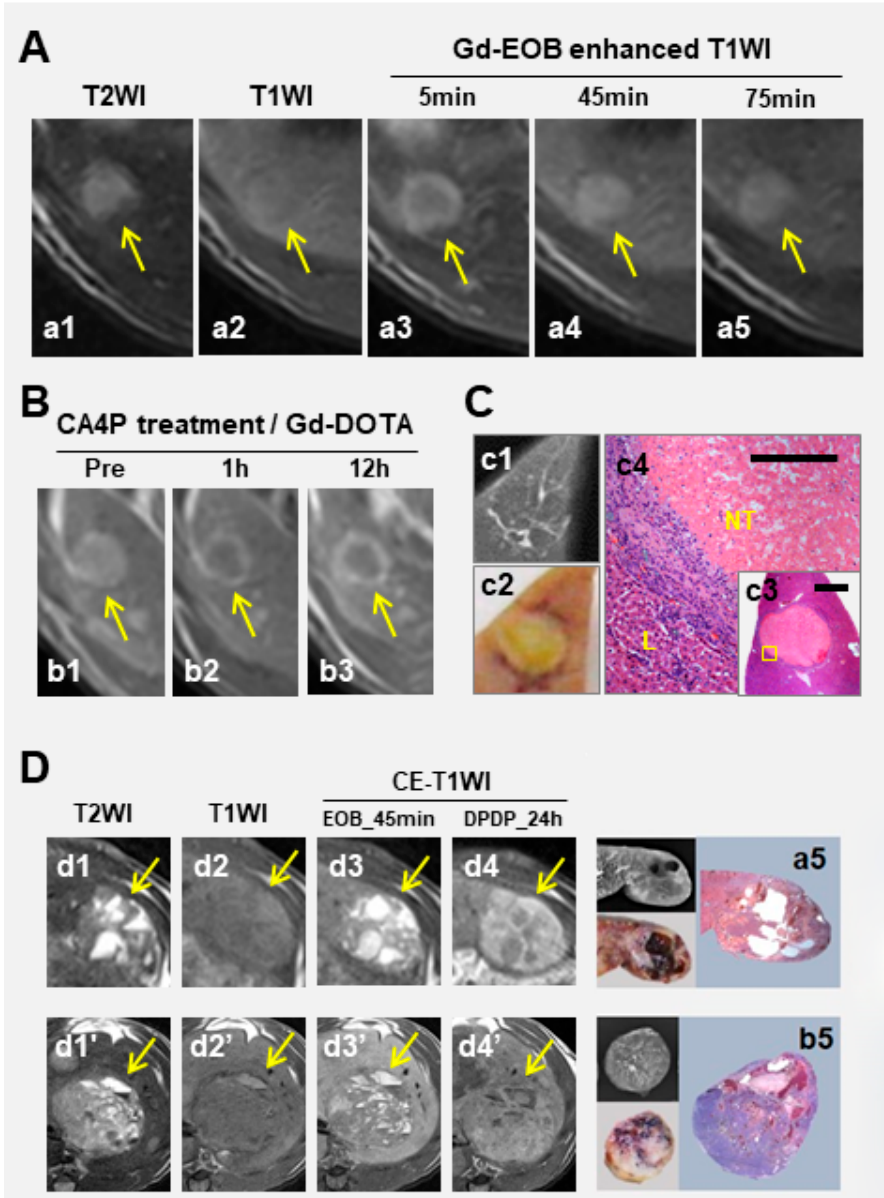
Figure 3. Performance of hepatobiliary contrast agents (CAs) on predicting tumoricidal effect of combretastatin A4 phosphate (CA4P) in well differentiated HCC, and on distinguish cystic foci. ( A ): A peripheral HCC lesion in the rat liver appeared hyperintense on T2WI (a1), isointense on T1WI (a2), and exhibited prolonged positive enhancement with Gd-EOB-DTPA on T1WIs throughout the hepatobiliary phase until 75 min (a3–a5), suggesting high di ff erentiation and good response to vascular disrupting agents (VDAs). ( B ): On gadoterate dimeglumine (Gd-DOTA) enhanced T1WIs, lesion appeared hyperenhanced before CA4P treatment (b1); but central hypointense surrounded by a hyperenhanced rim at 1h (b2) and 12h (b3) post treatment, indicating vascular shutdown and consequent tumoral necrosis. ( C ): Microangiogram showed faint vascular stain (c1) in the tumor as a lesion with clear margin on macrograph (c2), which was histopathologically classified a well-di ff erentiated HCC and proven nearly complete necrotic on both low (c3, original